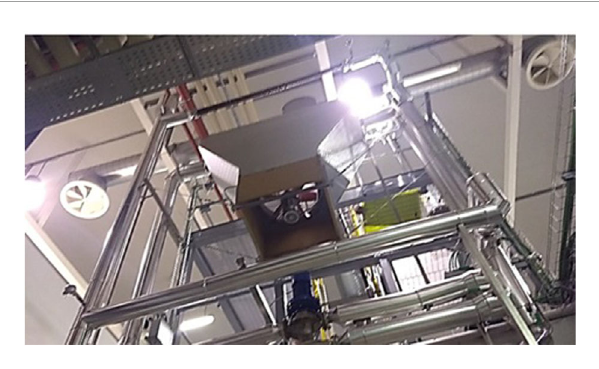
FIGURE 1 Picture of the coupled DYNASTY–eDYNASTY natural circulation loops as